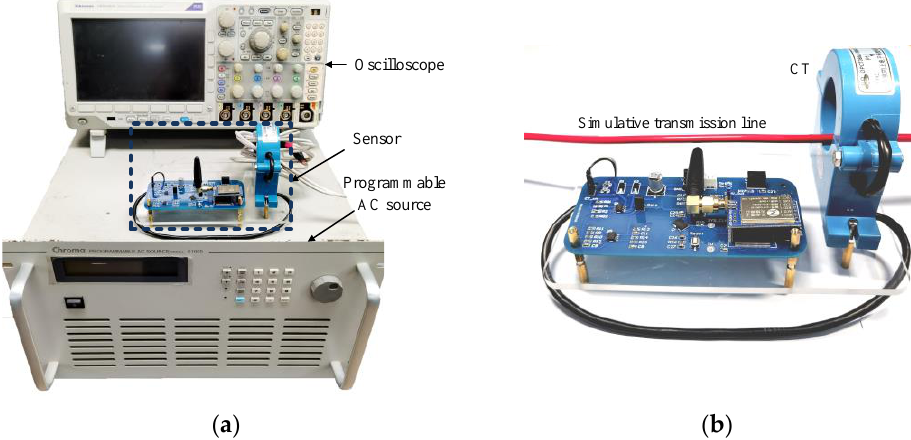
Figure 14. ( a ) Test bench for proposed sensor. ( b ) Prototype of the proposed current sensor.